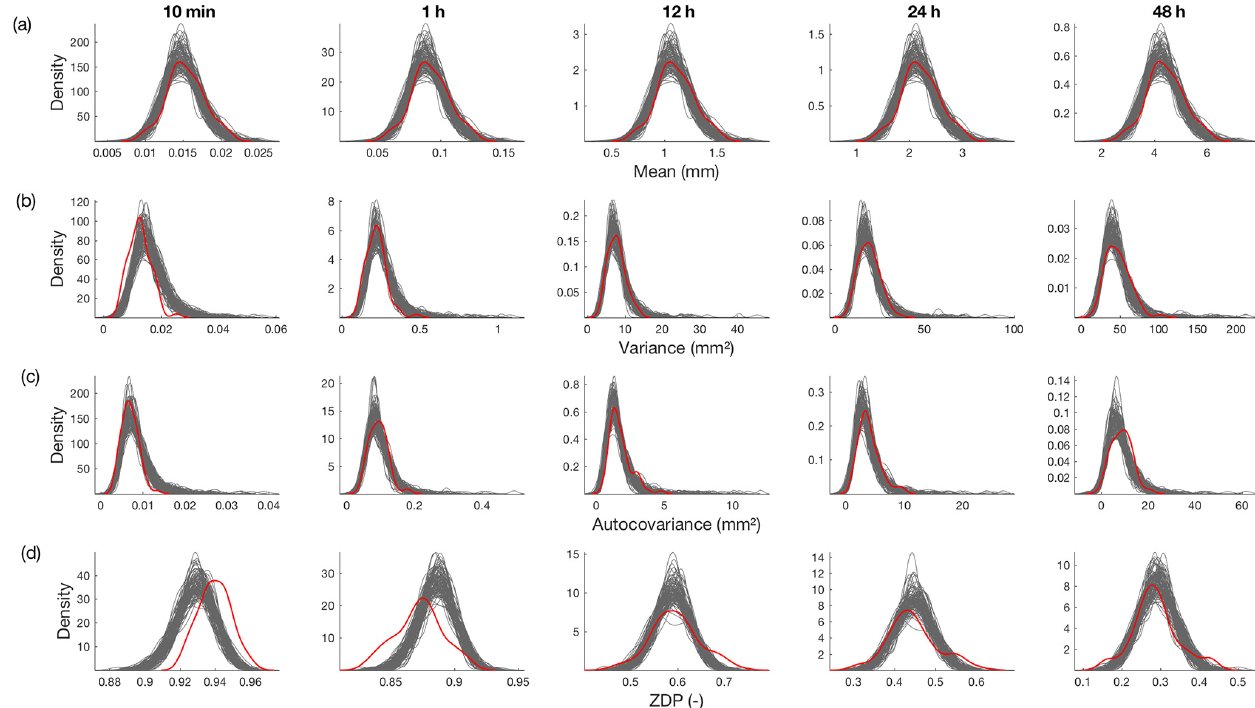
Figure 9. Comparisons between the probability density functions of mean, variance, autocovariance and ZDP calculated for the observed and simulated precipitation data for different aggregation levels for each year: Uccle is in red and the 50 simulated time series by the MBL model is in grey. Densities are shown for the (a) mean, (b) variance, (c) lag-1 autocovariance and (d) the zero-depth probability (ZDP).